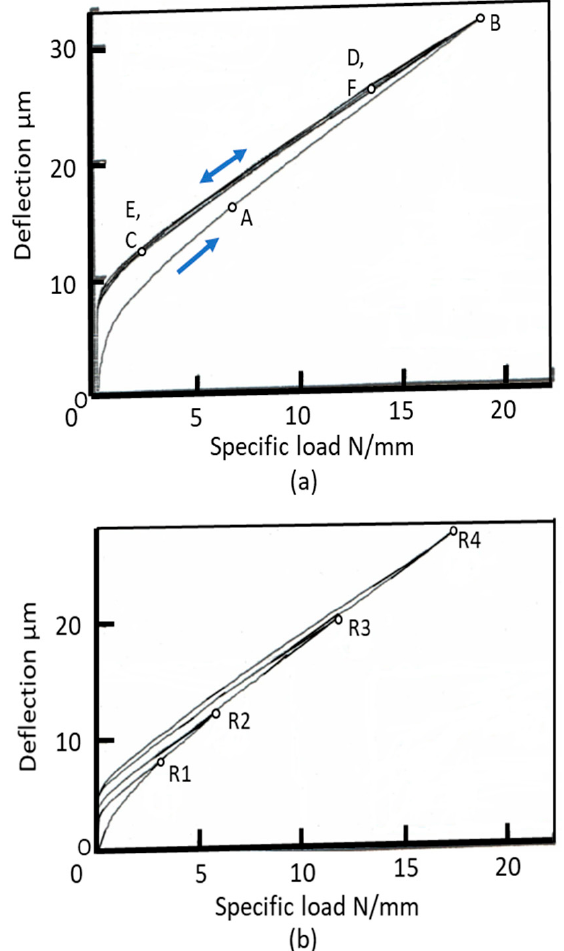
Figure 12. Repeatability of the measurements of wheel deflection, grinding wheel WA60J8V. ( a ) Same load cycle; ( b ) Incremental load cycle.